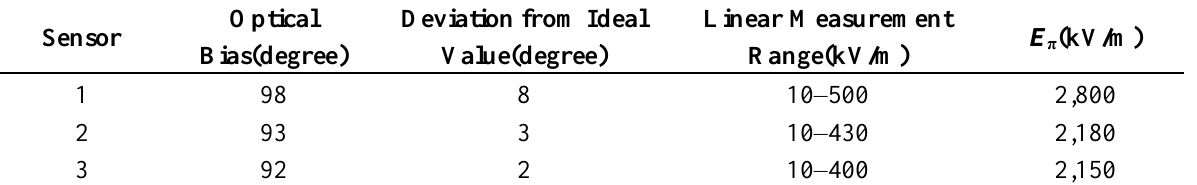
Table 1. Experimental parameters of CPI sensors with antenna and electrode.